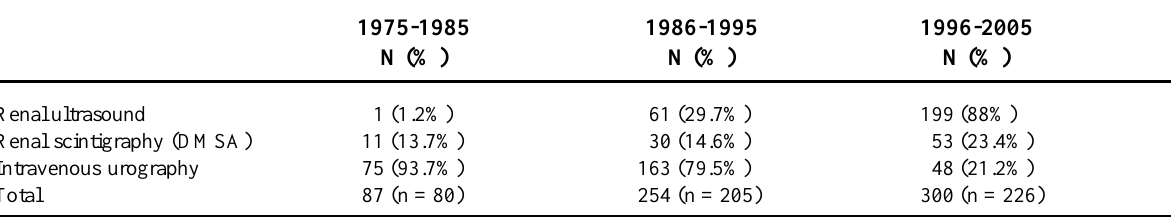
Table 2 – Tests carried out in the initial evaluation of the patients in the study groups.